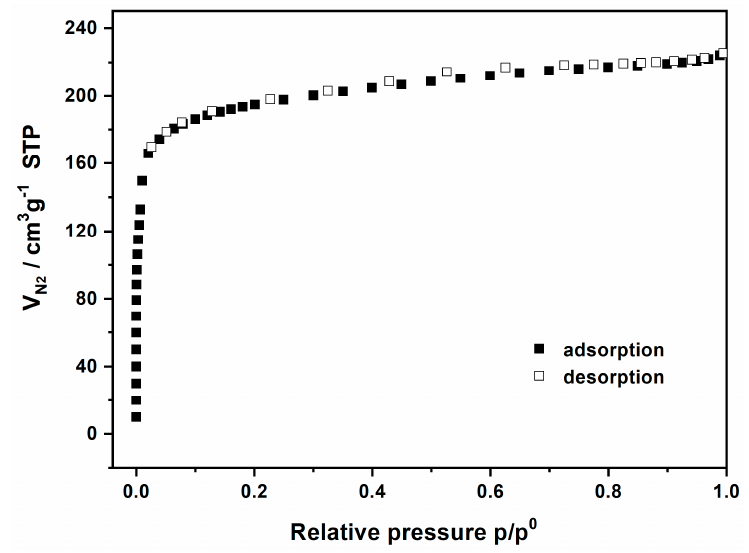
Figure 2. N 2 sorptionisothermsofMIL-68(Ga)_NH 2 . (Solidsymbols,adsorption; opensymbols,desorption). The room temperature UV-vis DRS of MIL-68(Ga)_NH 2 and MIL-68(Ga) samples as well as the H 2 BDC-NH 2 ligand are illustrated in Figure 3. The reflectance was converted to absorbance by the Kubelka–Munk method. The primary optical absorption band around 365, 390 nm for MIL-68(Ga)_NH 2 and H 2 BDC-NH 2 , respectively, should be arisen from the n – π * transition of the lone pair electrons of -NH 2 in the ligand [17,48]. Owing to the perturbation of the transition metal, the blue shift of optical response region is observed for MIL-68(Ga)_NH 2 versus free ligand [29]. Meanwhile, the optical response edge of the MIL-68(Ga)_NH 2 sample is evidently shifted to longer wavelength compared to the prototype MIL-68(Ga). The main absorption edges of MIL-68(Ga)_NH 2 and MIL-68(Ga) samples are 450 and 320 nm, respectively, corresponding to the band gaps (Eg) of 2.76 and 3.88 eV (Eg = 1240/wavelength). It reveals that both of the samples present semiconductor properties. The comparison of the two main absorption peaks shows that modification of the amino group is an effective means to expanding photoabsorption edge of MOFs into the visible light region, which is reflected obviously in color changing of the samples as illustrated in the inset of Figure 3.